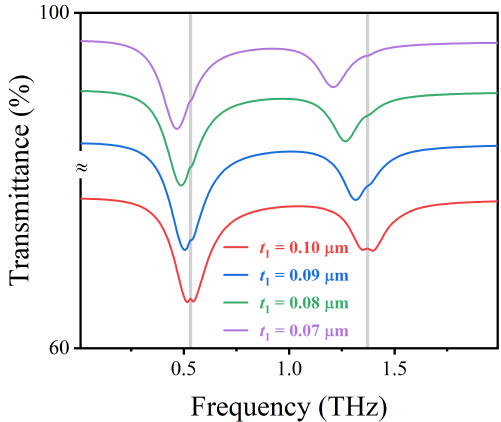
Figure 4. The transmission spectrum of AIGS at different lactose thicknesses t 1 under vertically incident TM